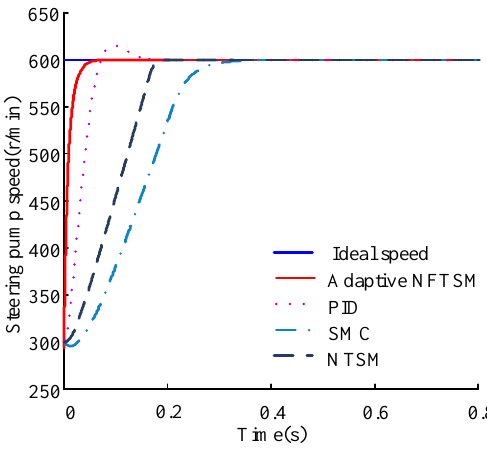
Figure 11. Speed response when input speed is fixed.